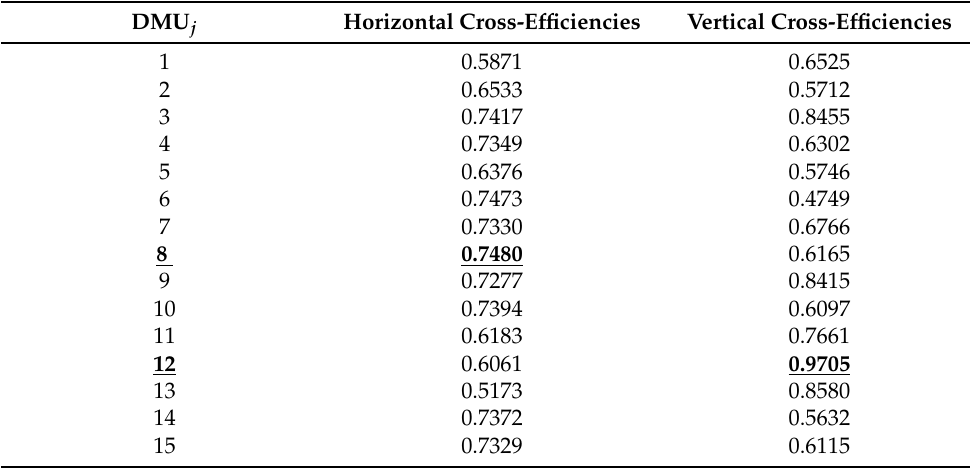
Table 5. Horizontal and vertical cross-efficiencies of 15